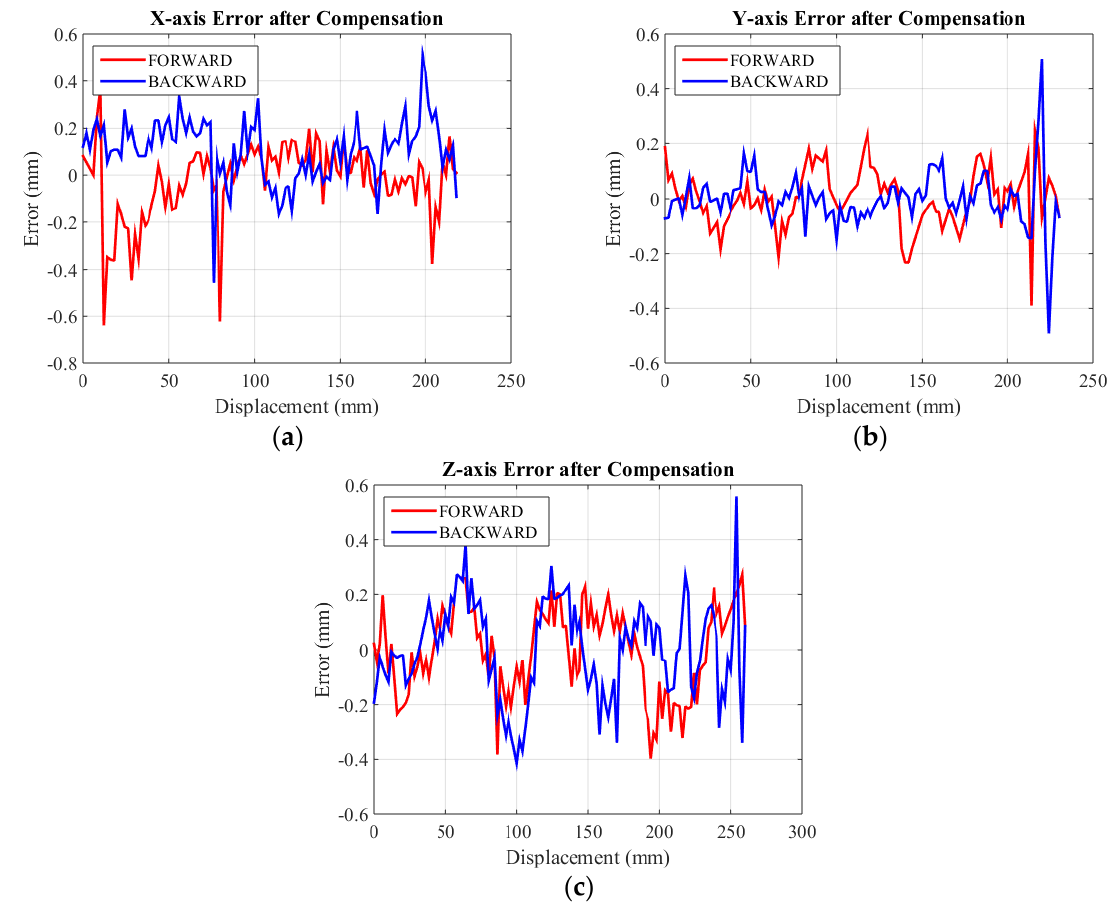
Figure 16. Displacement error after compensation of three axes. ( a ) Displacement error of X-axis ; ( b )